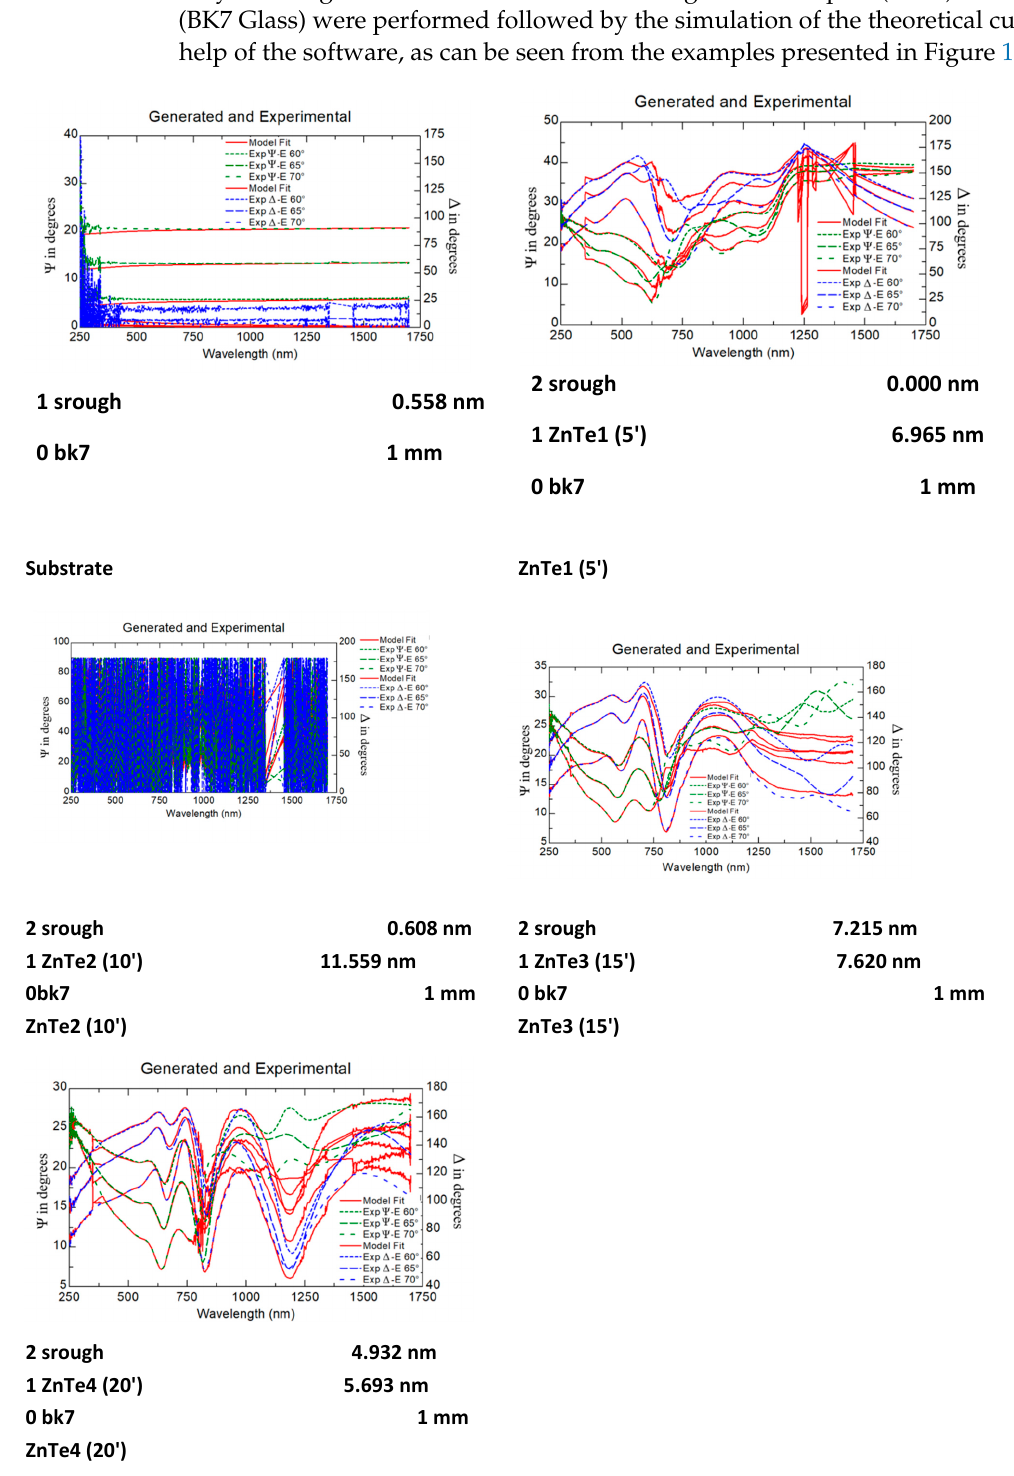
Figure 10. Theoretical and experimental ellipsometry data ( ∆ and Ψ ) of ZnTe thin films at three incidence